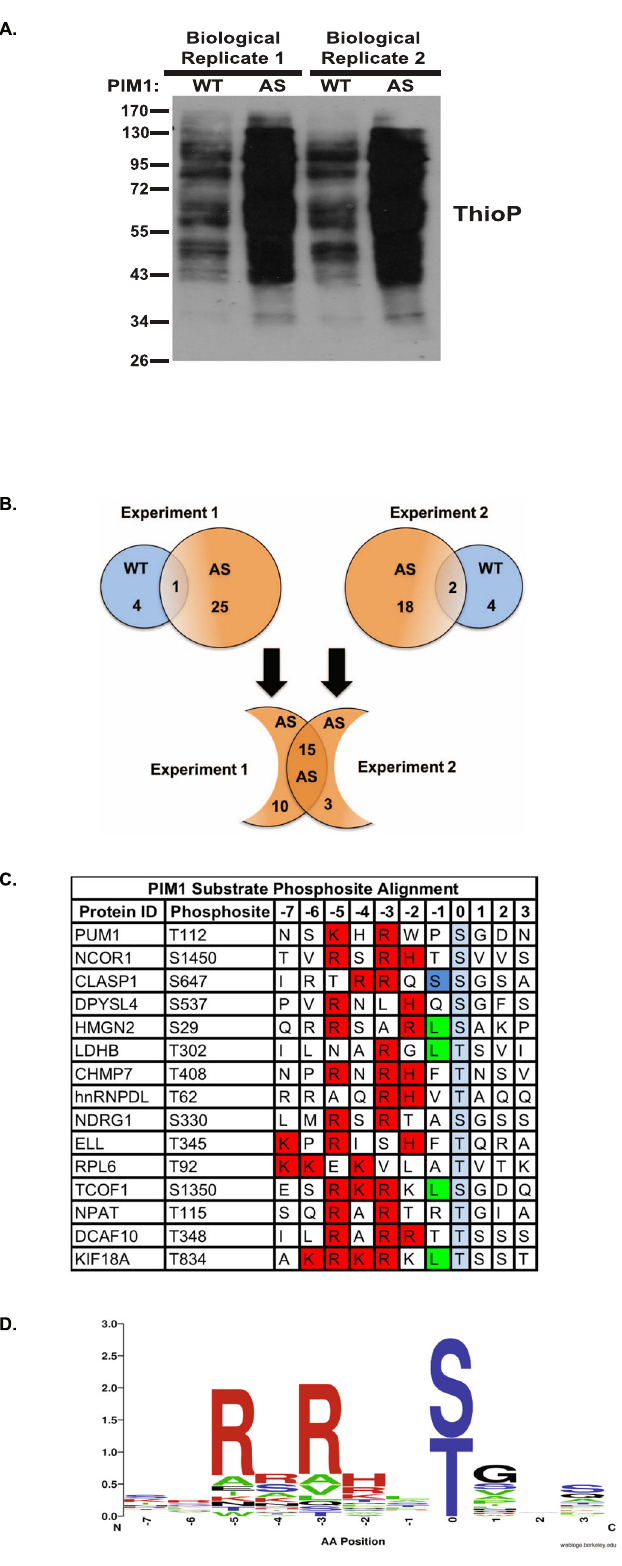
Fig. 2 Identi fi cation of high-con fi dence AS PIM1 substrates in prostate cancer cells. A Western blot of the thiophosphate ester moiety (ThioP) from biological replicates of LNCaP-WT PIM1 and LNCaP-AS PIM1 cell lysates, 0.1% used for the phosphopeptide enrichment. B Proteins identi fi ed from lysates used in Fig. 2A from two independent experiments. Blue and orange circles represent proteins identi fi ed in WT PIM1 and AS PIM1- expressing LNCaP cells, respectively. C PIM1 substrate phosphosite alignment. Highlighted residues represent optimal, amino acids based on PIM1 consensus sequence. Red, basic residues. Green, hydrophobic residues. Blue, neutral polar residues. D Consensus logo generated using substrates in